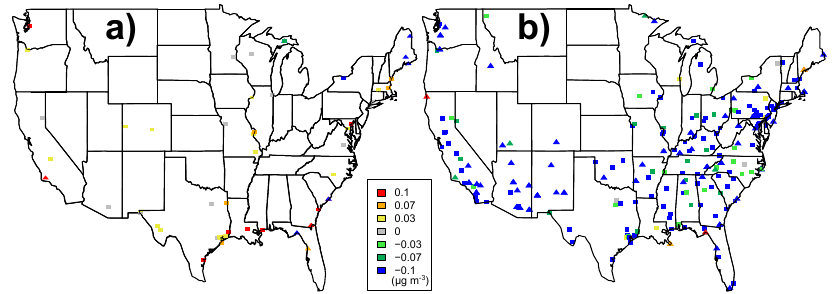
Figure 7. Model bias of PM 2 . 5 -sodium concentration predicted by the revised simulation compared to observations from the IMPROVE (triangles) and CSN (squares) networks for May 2002 segregated by an (a) increase or (b) decrease in the error relative to the baseline simulation. The map only includes data where the model percentage difference between the revised and baseline simulations is >